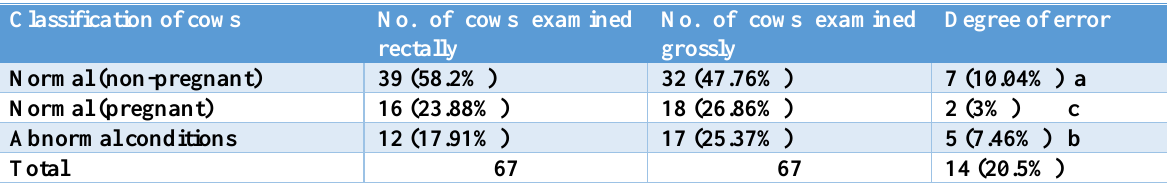
No. of cows examined Degree of error rectally grossly